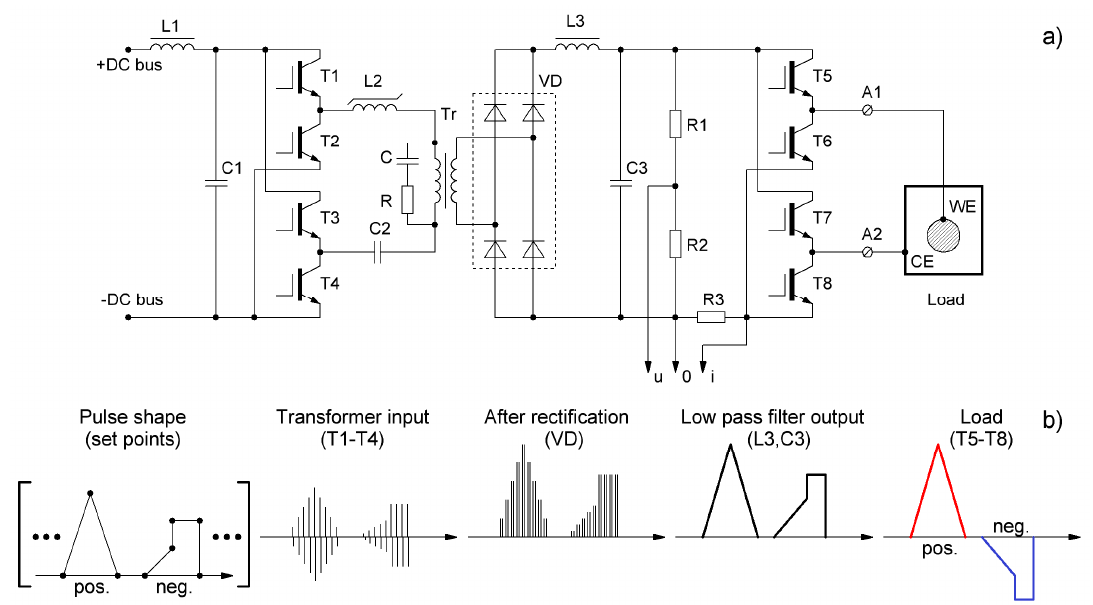
Figure 7. Schematic diagram of the double full-bridge power unit ( a ); simplified path of pulse shape from memory to the load ( b ).